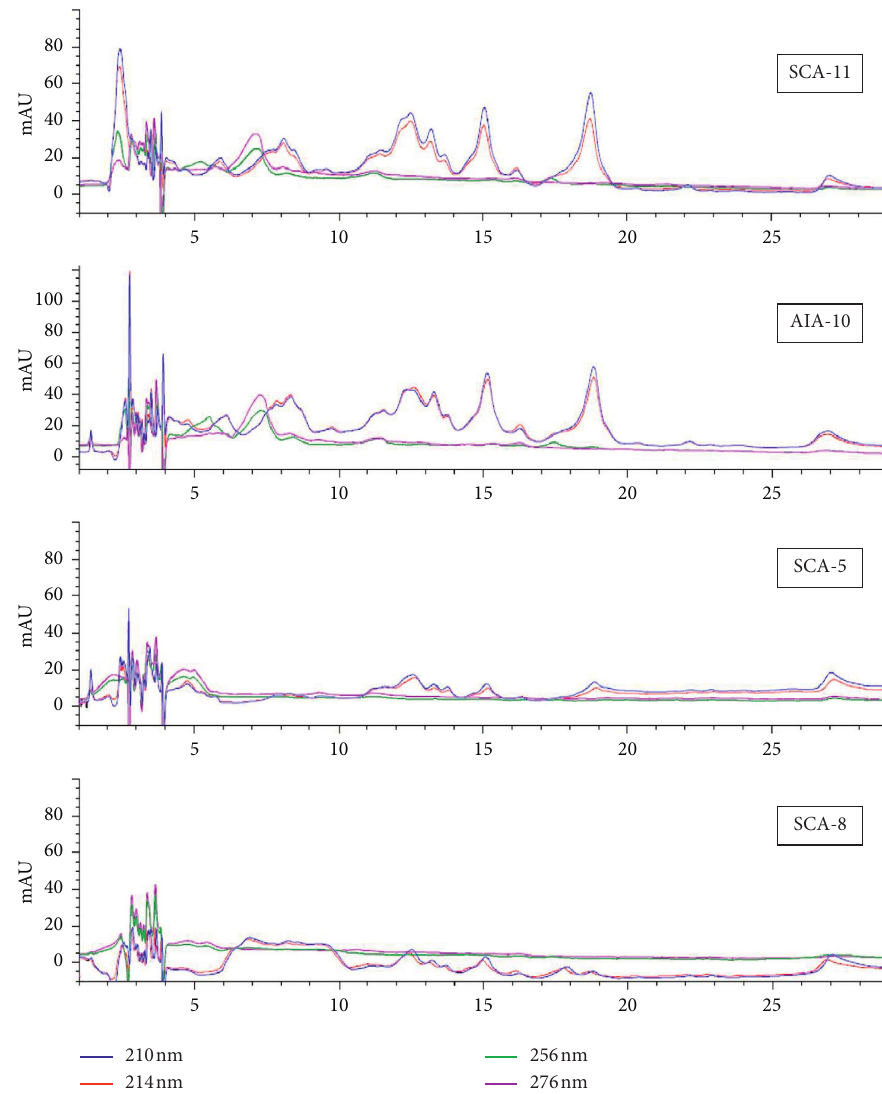
Figure 6: HPLC metabolite-crude-extract profile from four Streptomyces isolates detected at 210, 214, 254, and